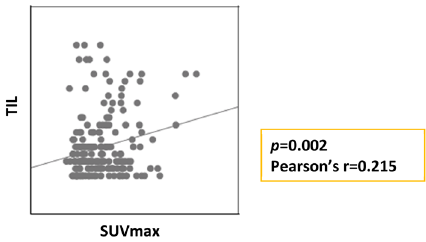
Figure 1. Correlation between the continuous maximum standardized uptake value (SUVmax) and tumor- infiltrating lymphocyte (TIL) levels.